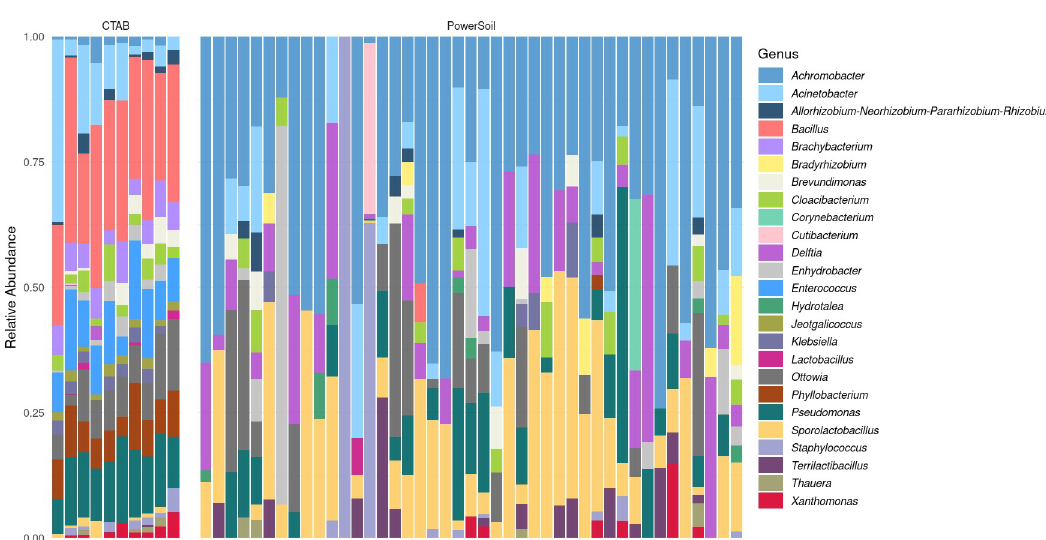
Fig 5. Proportional abundance bar plot of SourceTracker-selected samples. Samples were filtered normally and with SourceTracker and ASVs were filtered normally and with decontam. Each bar represents the bacterial composition of a single sample; bars 1–10 and 11–53 correspond to CTAB- and PowerSoil-extracted samples, respectively. ASVs were collapsed by genus, and the 16S rRNA fractions accounted for by each genus are shown in different colors.